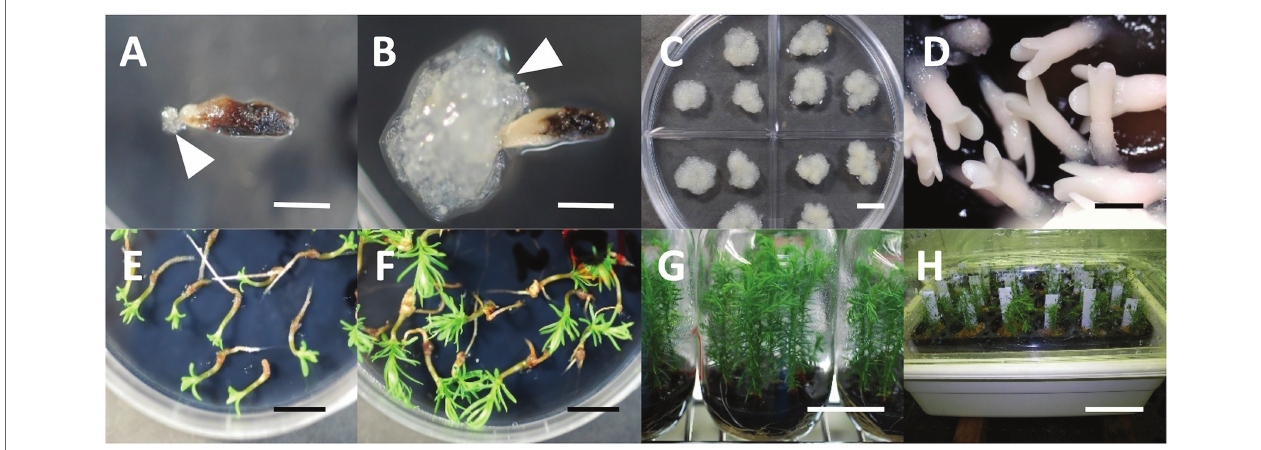
FIGURE 1 | SE and plant regeneration in sugi (Japanese cedar, Cryptomeria japonica ), (A) extrusion of ECs (arrow) from megagametophyte explant, (B) established ECL (arrow represent ECs), (C) maintenance/proliferation of ECs, (D) cotyledonary embryo formation from ECs, (E) embryo germination, (F) plantlet conversion, (G) in vitro growth of plantlets, (H) acclimation of somatic plants. Bars : 5 mm (A,B,D) , 1 cm (C,E,F) , 5 cm (G) , and 10 cm (H)